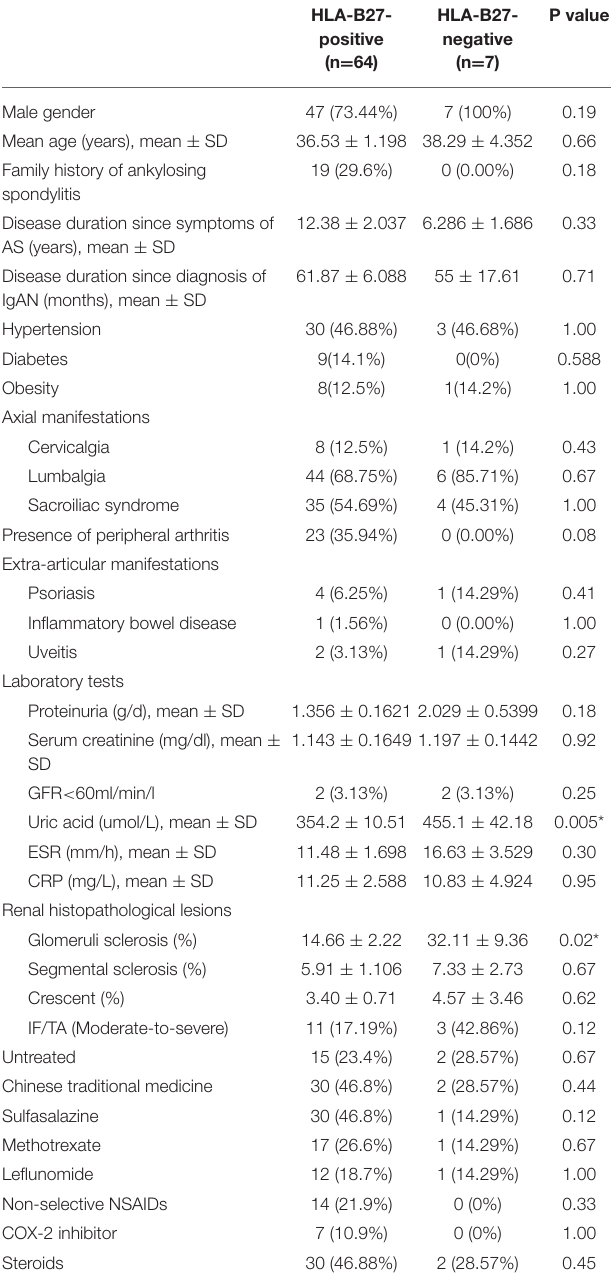
TABLE 1 | Baseline demographic and clinical characteristics of HLA-B27-positive and HLA-B27-negative patients with secondary